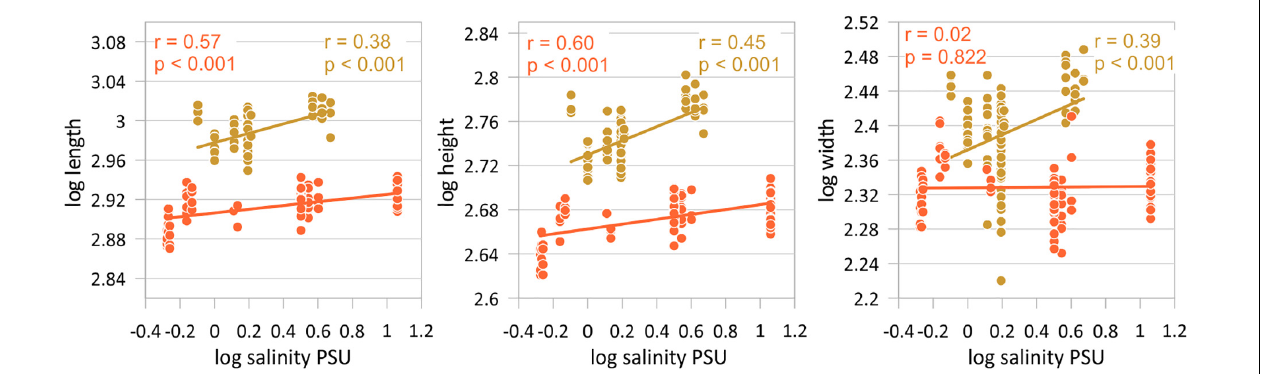
FIGURE 4 | Correlations between valve length, height, and width and salinity separately for both morphotypes (orange = morphotype I, gold = morphotype II). Displayed are female left valves. Results of the other correlation analyses are given in Table 4 .